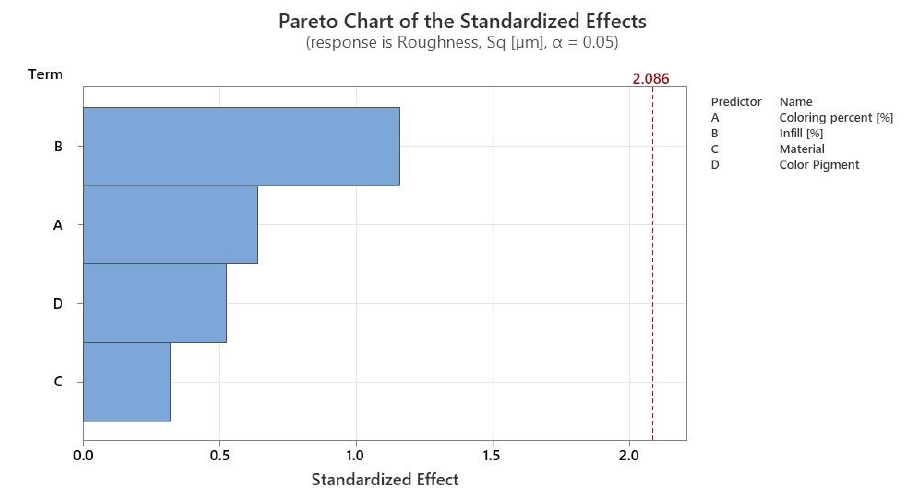
Figure 18. Pareto graph for the significance level of the studied factors for surface roughness.